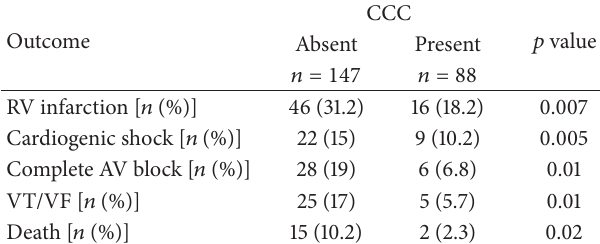
Table 3: Clinical outcome according to presence and absence of CCC.